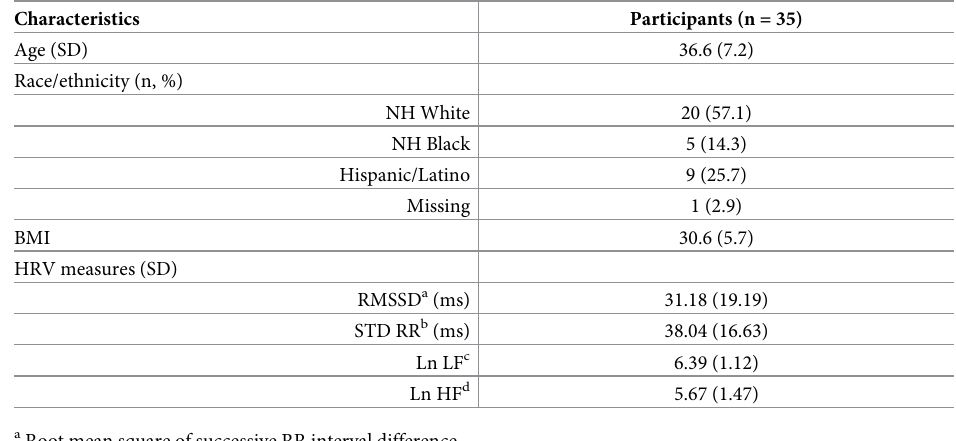
Table 1. Descriptive characteristics of participants.